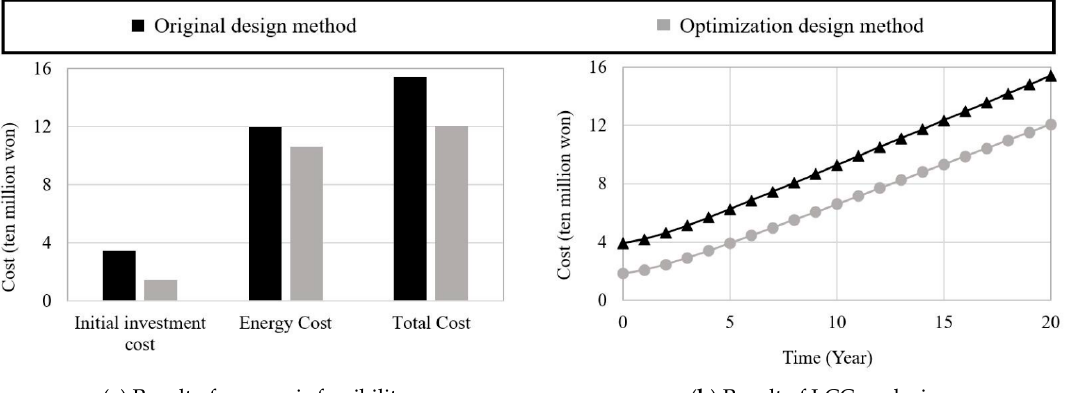
Figure 11. Result of economic analysis; ( a ) comparison of economic feasibility between the existing design method and the optimized design method for initial investment cost, energy cost, and total cost. ( b ) LCC comparison analysis result between the existing design method and the optimized design method